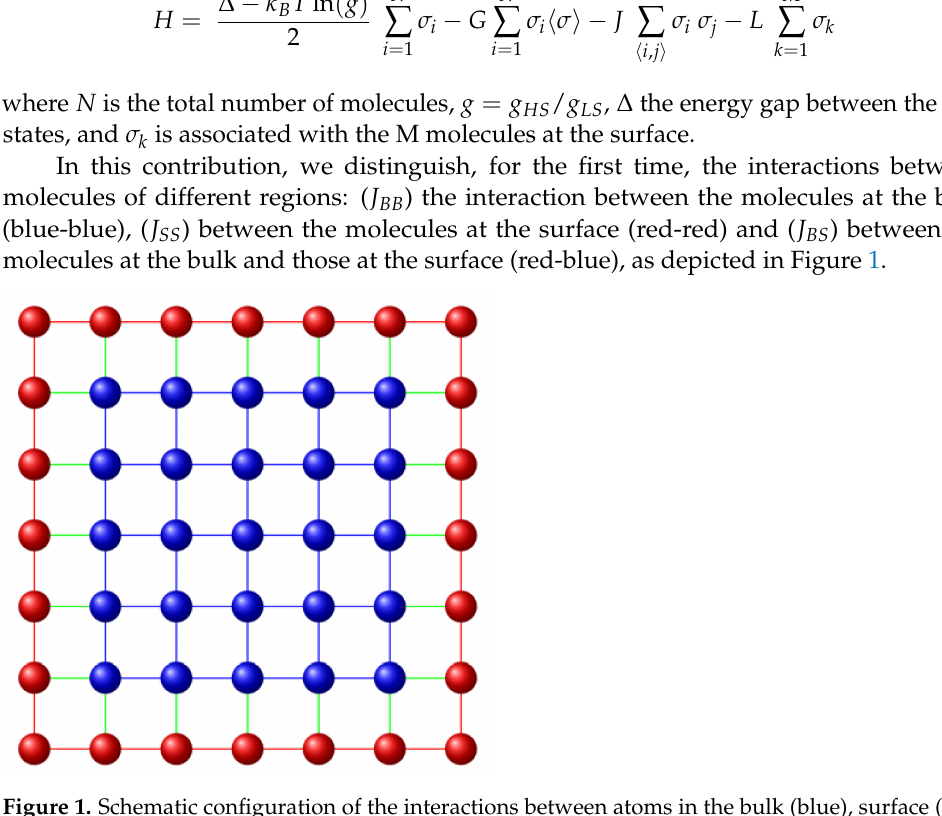
Figure 1. Schematic configuration of the interactions between atoms in the bulk (blue), surface (red), and bulk-surface